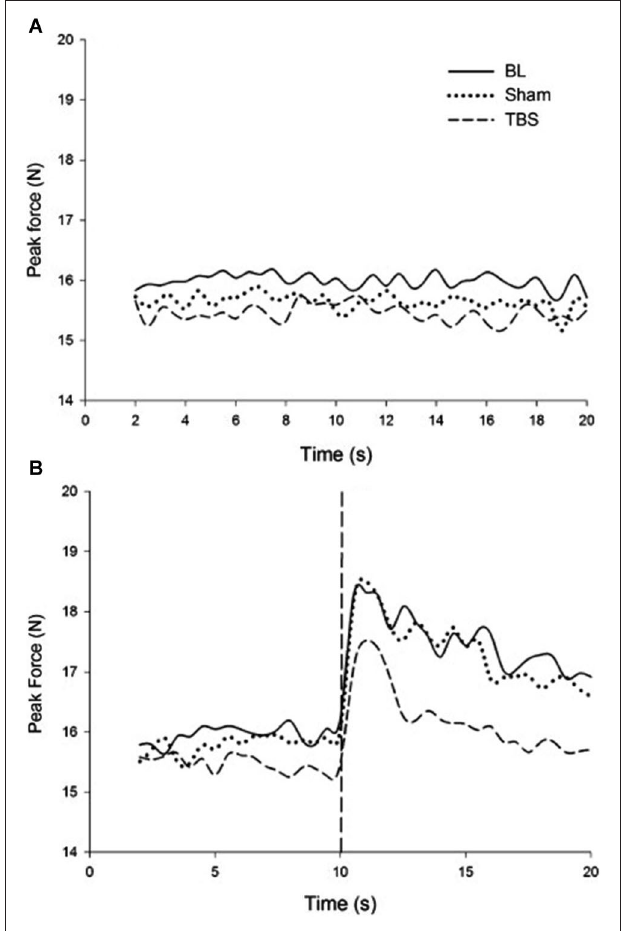
FIGURE 2 | (A) Force produced during rhythmic entrainment. (B) Force produced during rhythmic entrainment when the entraining stimulus is extinguished at 10 s. It is readily noticed that the force escalation effect that is pronounced in the baseline and sham condition is reduced due to cTBS (reproduced with permission from Therrien et al.,